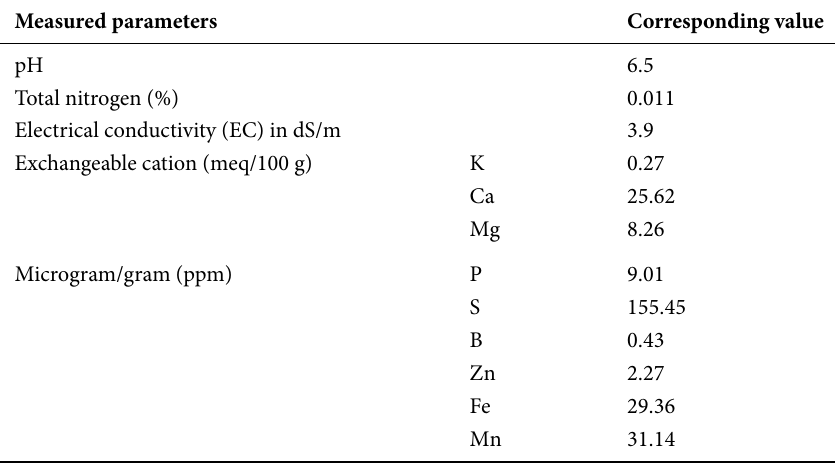
Table 1 Physical and chemical properties of the soil before starting the